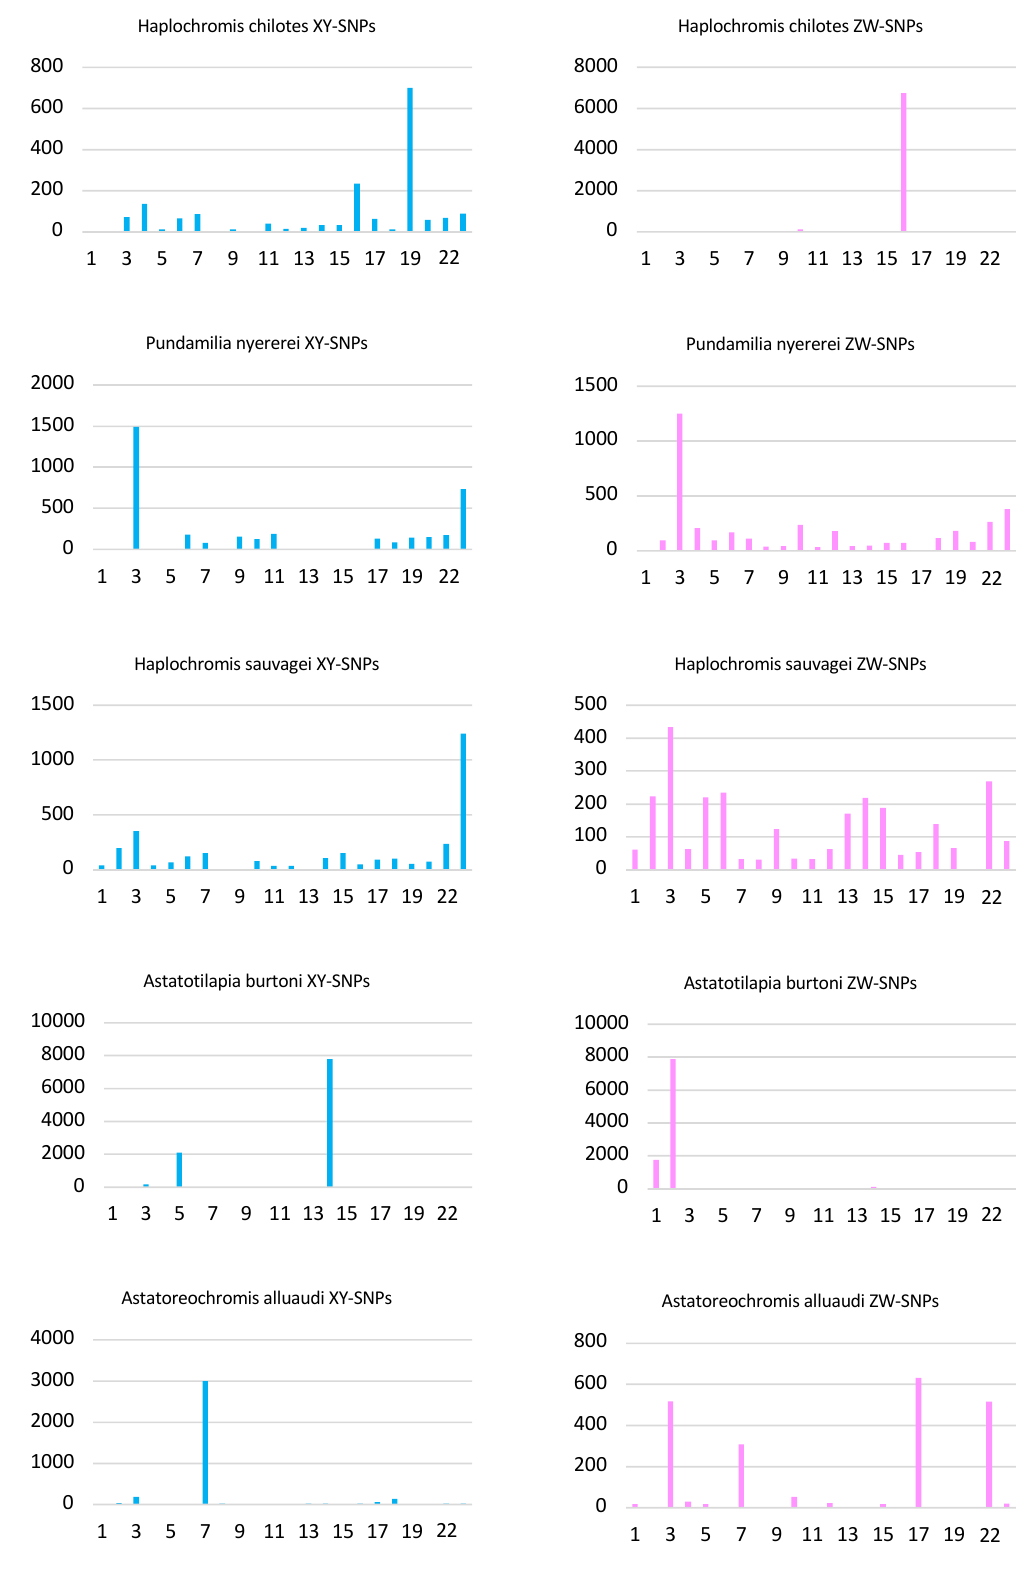
Figure 3. Analysis of sex-patterned SNPs in 100 kb windows. The number of SNPs in the top 1% of windows are plotted for both XY- and ZW-patterned SNPs in each of the five species. The x-axis represents linkage groups in the Maylandia zebra UMD2a assembly.